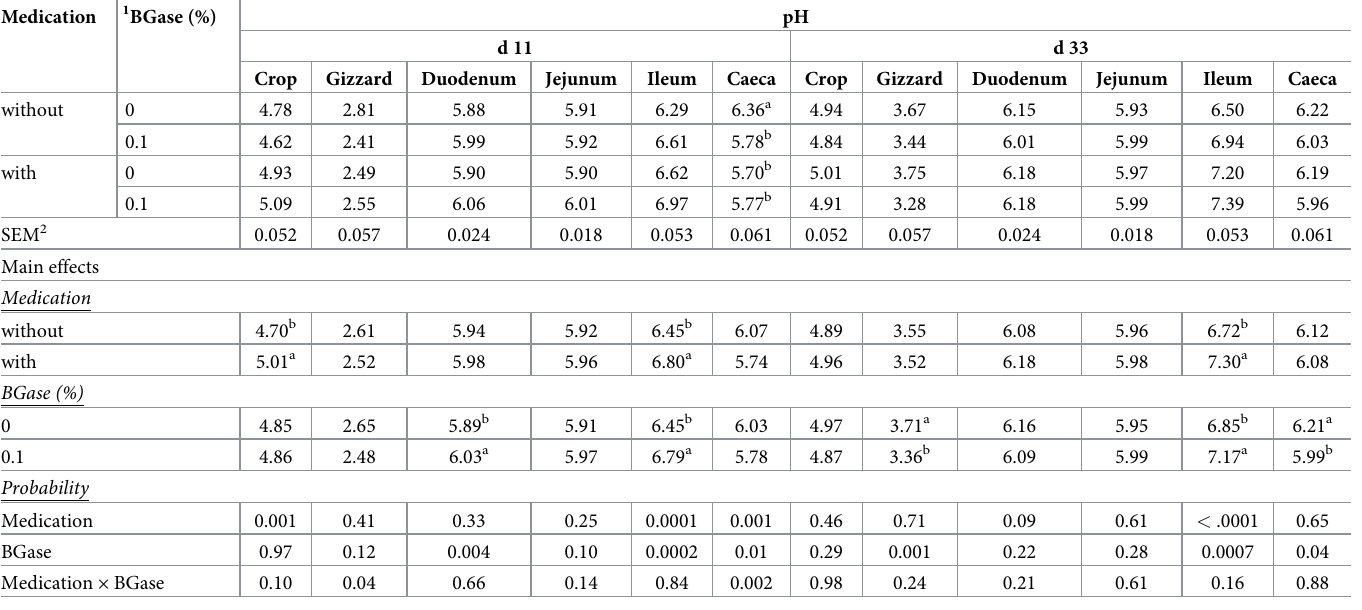
Table 14. Effects of diet medication and diet on gastro-intestinal pH of broiler chickens (Experiment 2).